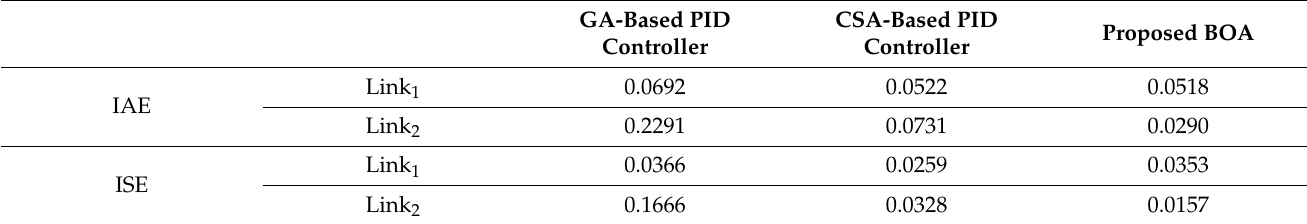
Table 2. The IAE and ISE performance indexes values based on each algorithm.